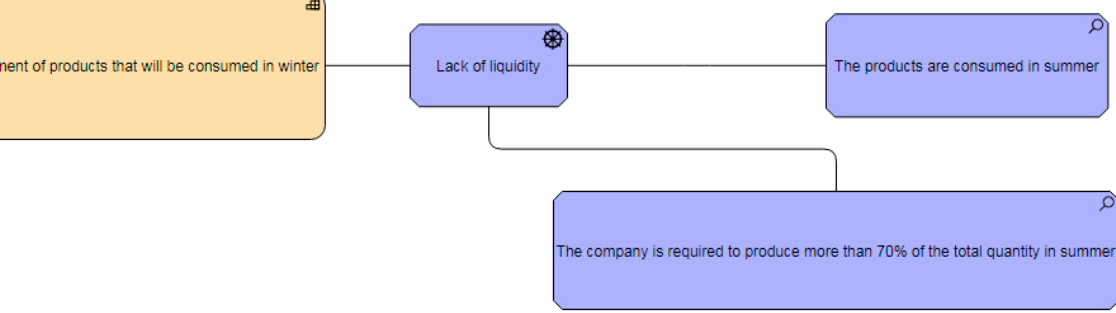
Figure 6. Link between capabilities and external factors.